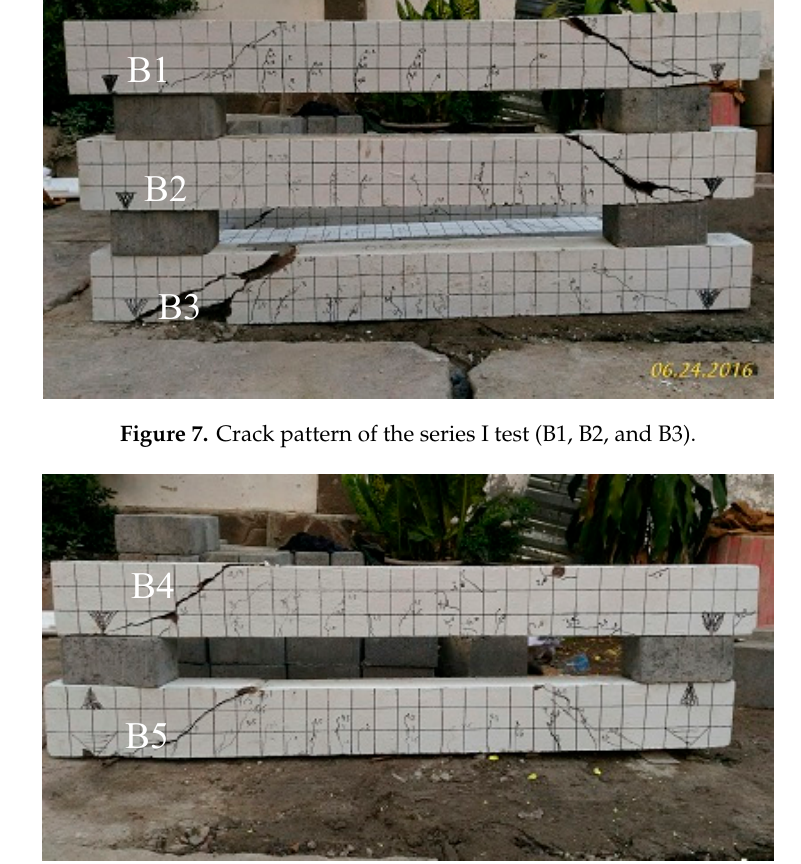
Figure 8. Crack pattern of the series II test (B4 and B5).